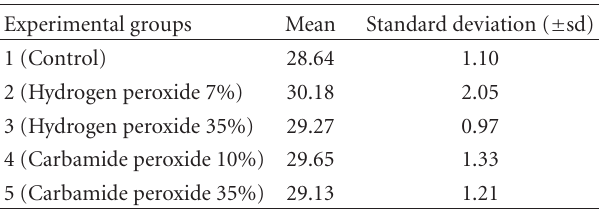
Table 2: Mean and standard deviation ( ± sd) Δ E values for all experimental groups.